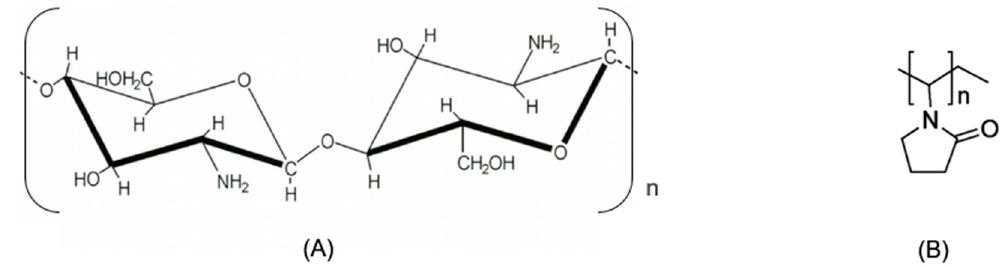
Figure 1. Chemical structure of: ( A ) chitosan; ( B ) Poly(vinylpyrrolidone) (PVP).